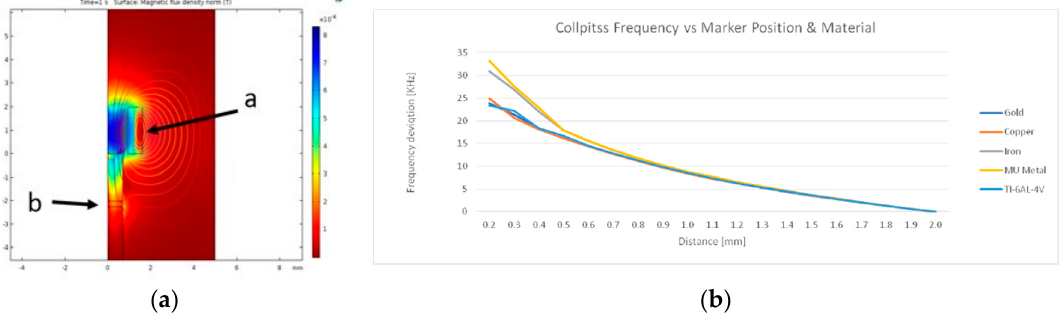
Figure 2. ( a ) COMSOL coil-marker simulation to determine magnetic behavior and coil inductance change. With a . the ½ modeled coil and b . the marker; ( b ) Simulated Colpitts frequency deviation as a function of marker to coil